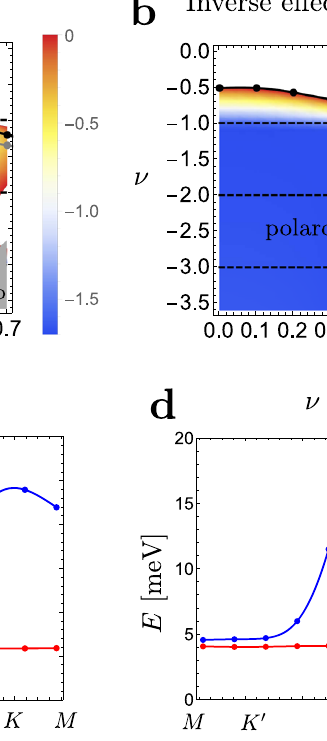
corresponds to the minimum bandwidth, and the gray shaded area is wherebands overlap and our analysis becomes invalid. b The corresponding inverse effective mass at the bottom of the band. The phase boundary is well approximated by the value m e / m eff ≈ 3. c , d are the spectra for electron doping the ν = − 1 and ν = − 3 insulators,